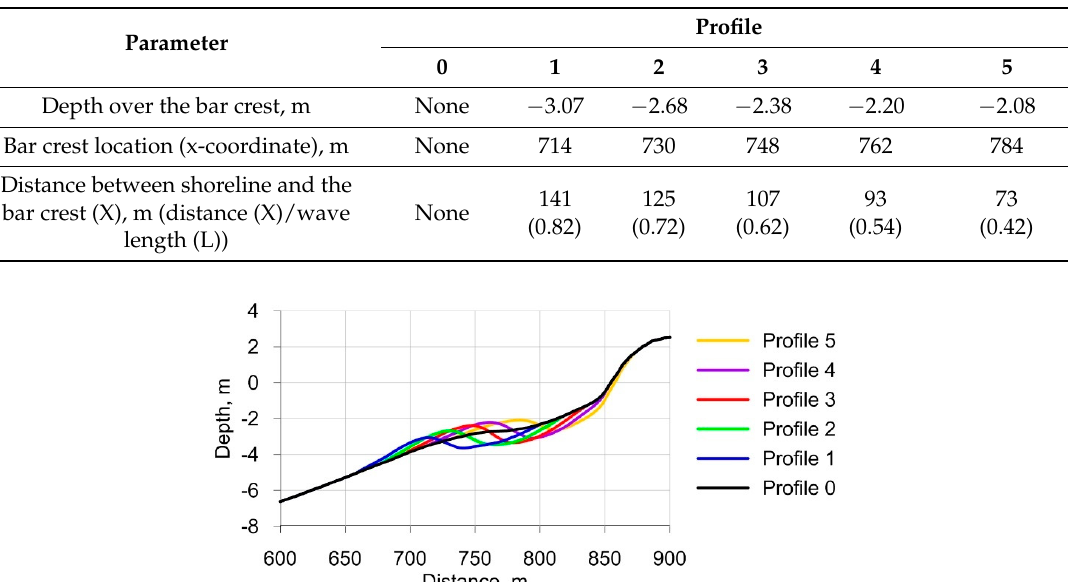
Table 1. Parameters of the initial profiles.